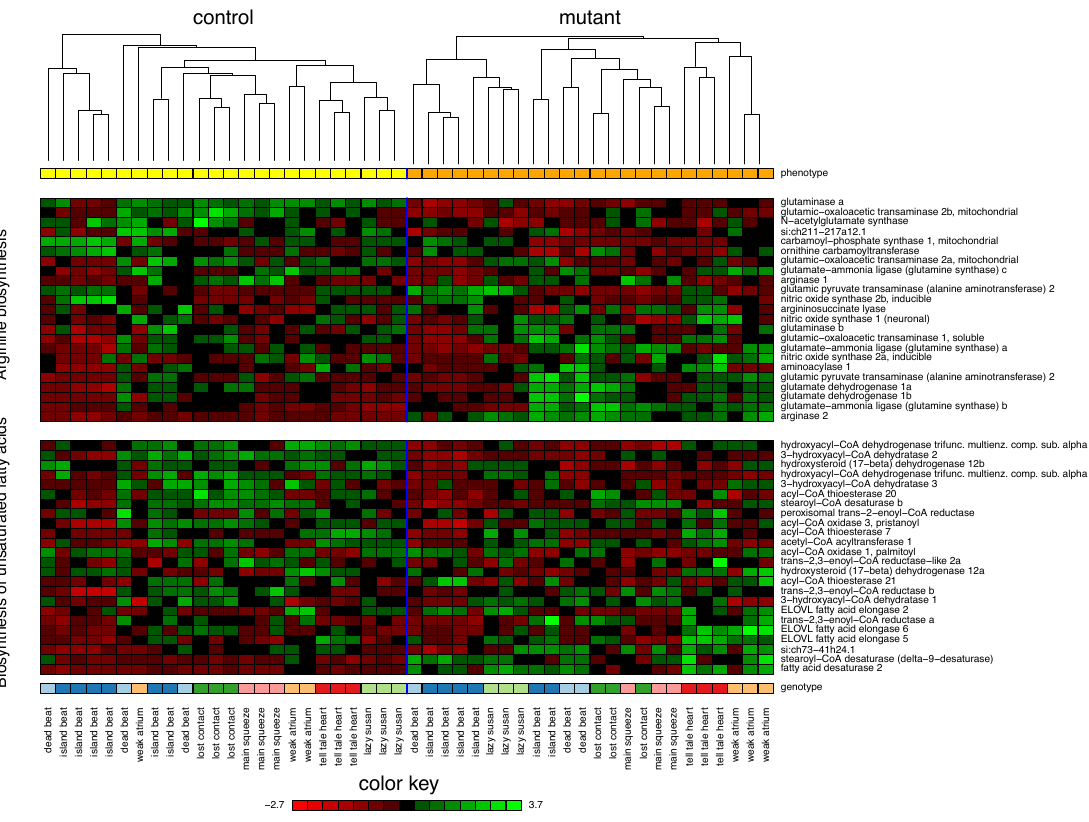
Figure 2. Heatmap of the two most frequently selected KEGG terms arginine biosynthesis (75%) and biosynthesis of unsaturated fatty acids (55%) in zebrafish. The figure provides the gene expression levels of the genes these terms comprise. Within each term, the genes are ordered according their Spearman correlation to the class label (mutant/control). Each gene was z -transformed individually. Within each class, hierarchical clustering (average linkage) was used to organize the